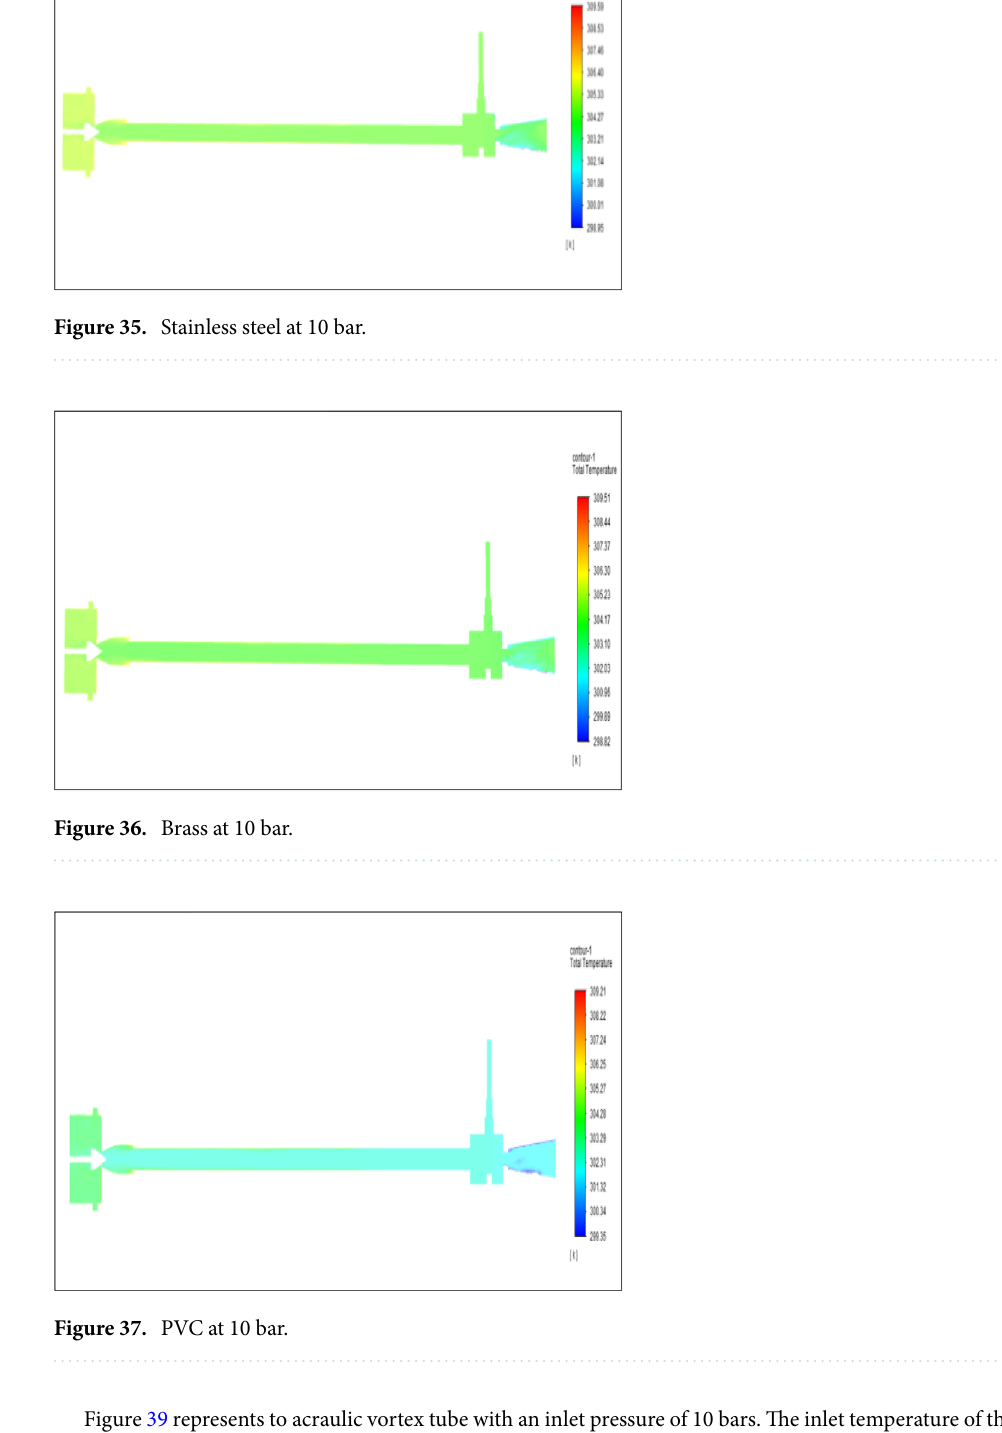
Figure 39 represents to acraulic vortex tube with an inlet pressure of 10 bars. The inlet temperature of the VT is 303 K. The hot air temperature was obtained at the hot end as 309.20 K. Similarly, the cold end side obtained a value of 299.35 K. The maximum temperature difference was noticed as 9.86 K. Figure 40 represents to nylon vortex tube with an inlet pressure of 10 bars. The inlet temperature of the VT is 303 K. The hot air temperature was obtained at the hot end as 309.37 K. Similarly, the cold end side obtained a value of 299.70 K. The maximum temperature difference was noticed as 9.67 K.